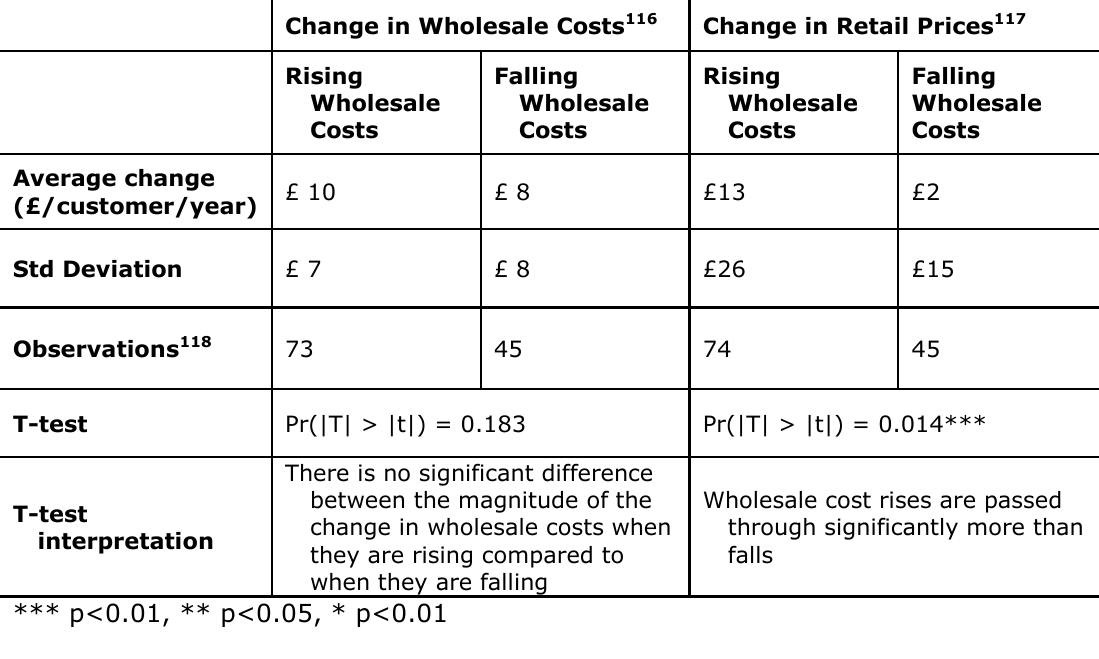
Figure 37: Changes in wholesale costs and retail